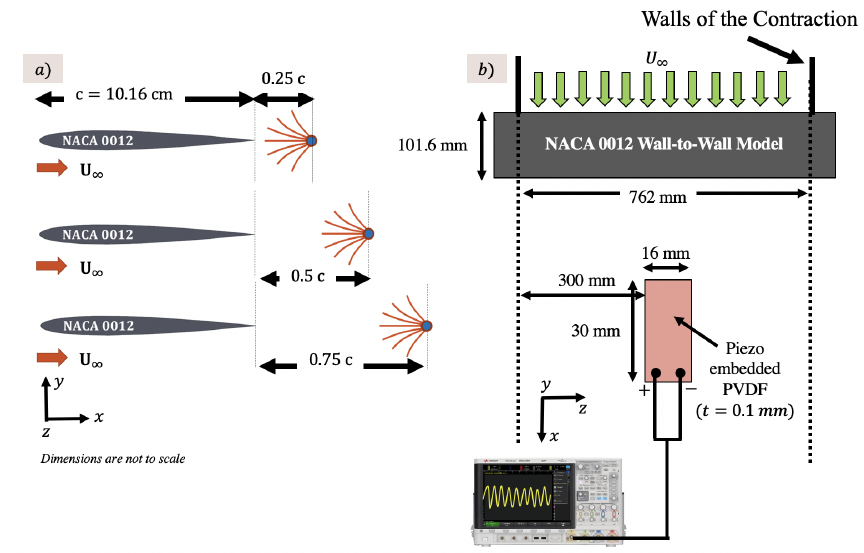
Figure 9. Schematic of ( a ) side view; ( b ) top view of NACA 0012 wall-to-wall model test setup.